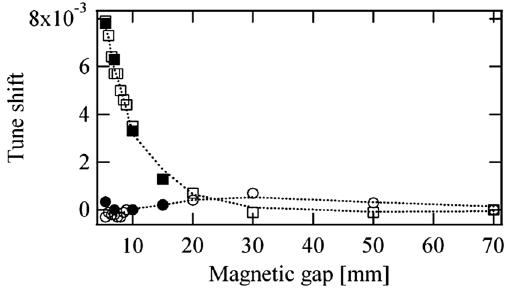
FIG. 10. Tune shift induced by the wiggler versus magnetic gap. Vertical ( h ) and horizontal ( (cid:8) ) tune shifts measured with the electron beam. Vertical ( j ) and horizontal ( deduced from the magnetic measurements.